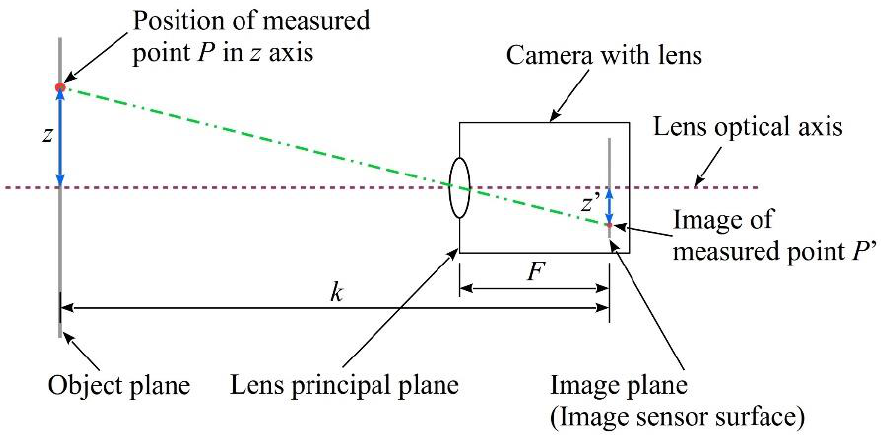
Figure 5. Principle of optical mapping—a basis for vision monitoring method.